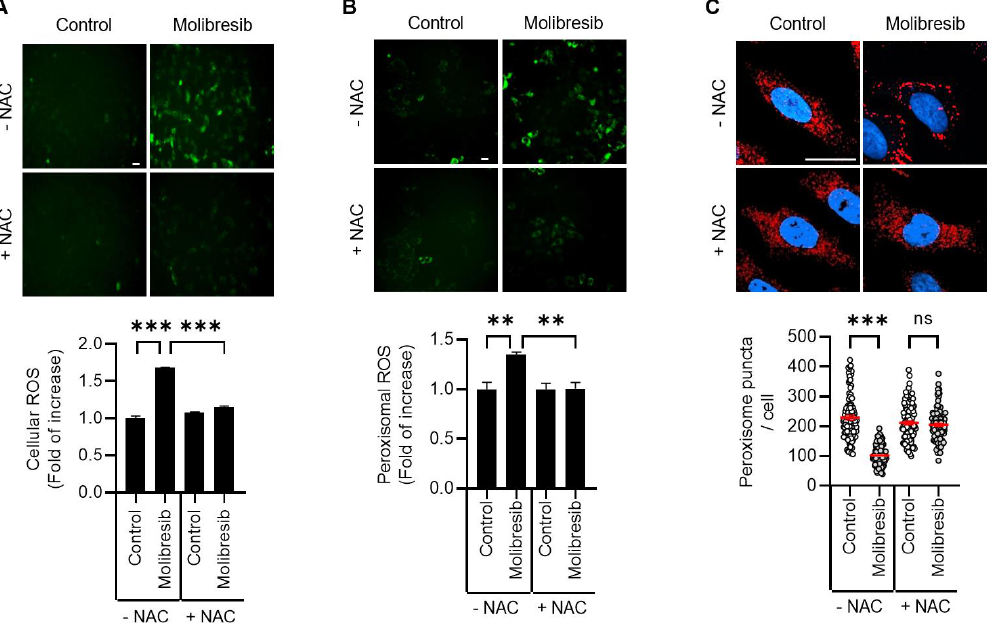
Figure 3. Inhibition of BRD4 promotes pexophagy by increasing the ROS levels in HeLa cells. ( A ) HeLa cells were treated with molibresib (10 µ M) with or without NAC (1 mM) for 48 h. Then, the cells were incubated with fluorescent DCFH-DA dye (10 µ M, 10 min). The cells were imaged (scale bar 50 µ m), and DCFH-DA fluorescence intensity was measured using image processing software ImageJ; ( B ) HeLa/pexo-HyPer cells were treated with molibresib (10 µ M) with or without NAC (1 mM) for 48 h. The level of peroxisomal H 2 O 2 was imaged (scale bar, 50 µ m) and measured using the fluorescence intensity of HyPer-PTS1; ( C ) HeLa cells were treated with molibresib (10 µ M) with or without NAC (1 mM) for 48 h. Then, the cells were immunostained with anti-ABCD3 antibody (red) and Hoechst 33,342 dye (blue) to count the number of peroxisomes in cells. Representative cell images are presented ( C , scale bar 20 µ m). The experiments were repeated at least three times. (Data indicate means ± S.E.M. ** p < 0.01, *** p < 0.001, ns: not significant).